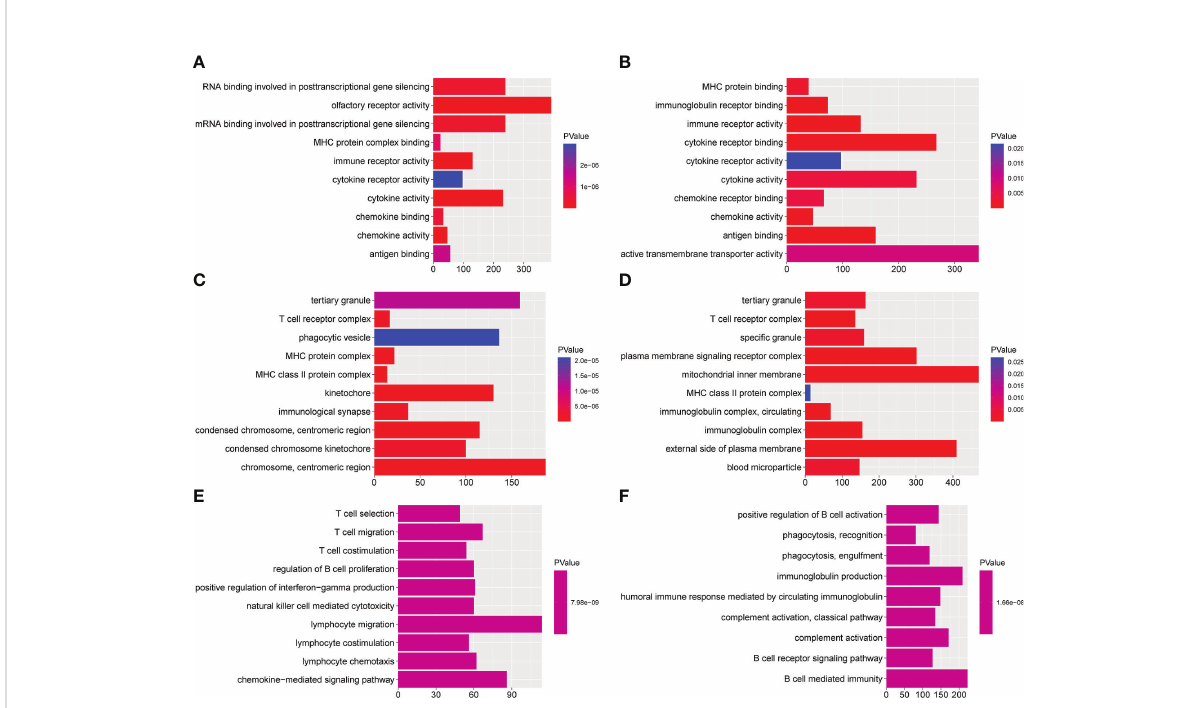
FIGURE 5 Gene Ontology analysis in the discovery set and validation set. The histogram map of the immunotype-associated molecular function in the discovery set (A) and validation set (B) , cellular component in the discovery set (C) , and validation set (D) and biological process in the discovery set (E) and validation set (F)